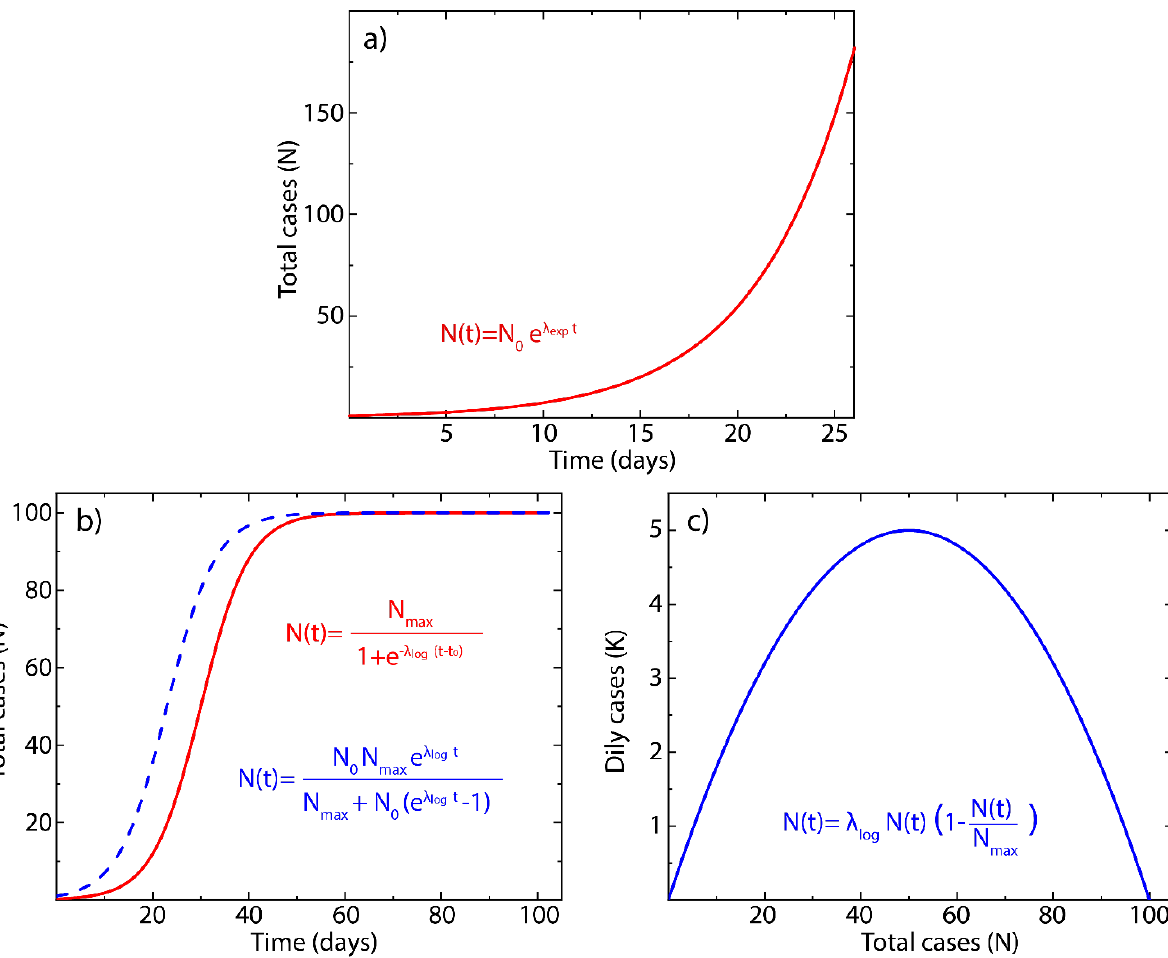
Figure 1. Illustration cases: a) the total number of cases as a function of time using the exponential model, b) the total number of cases as a function of time. The discrete logistic equations (red line) are compared to the solution of the ODE logistic model (dashed blue line), and c) the daily cases as a function of total cases. Parameters used: 𝑵 𝝀 𝒆𝒙𝒑 = 𝟎.𝟐 (day -1 ), 𝒕 𝟎 = 𝟑𝟎